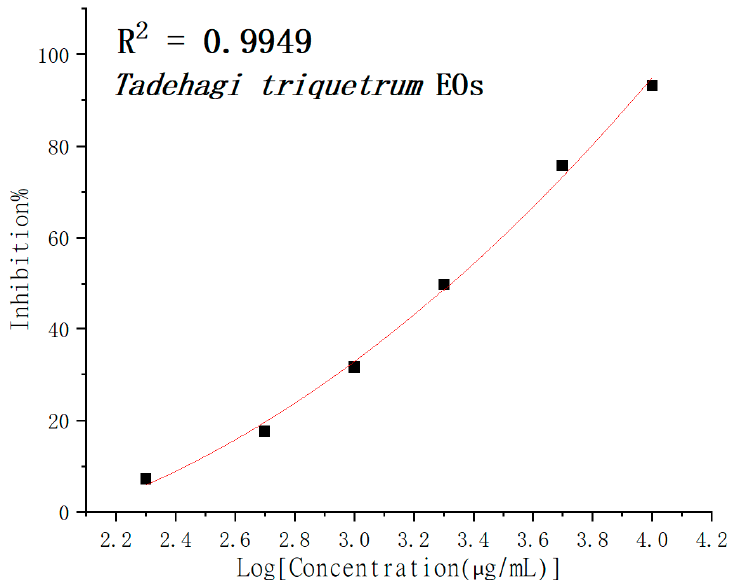
Figure 3. The percentage of the inhibitory effect of the essential oil of T. triquetrum in the ABTS assay.